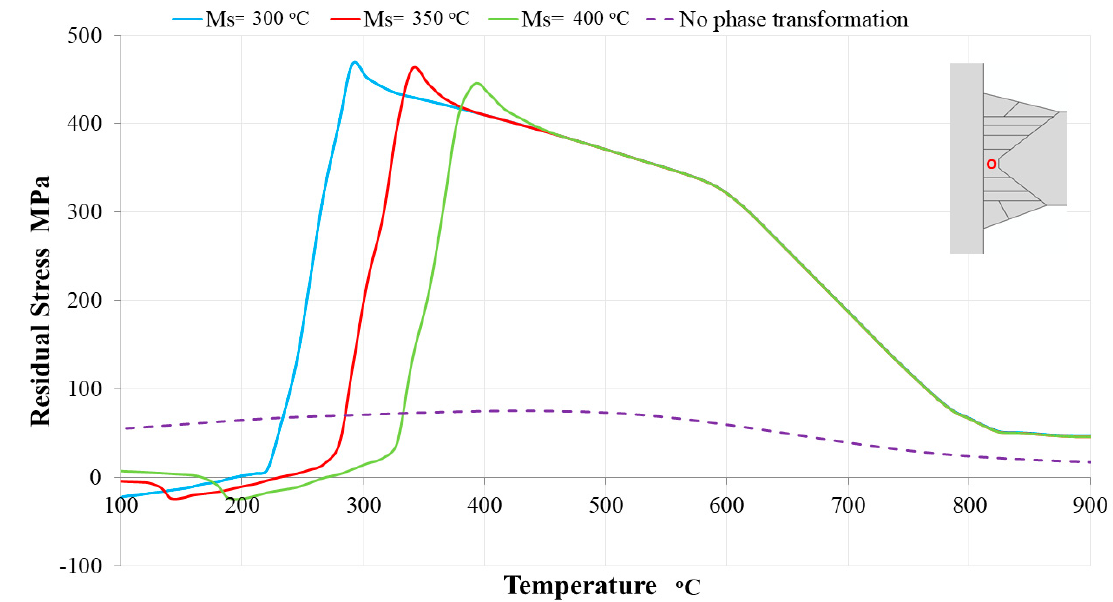
Figure 12. Stress accumulation at the 1 st bead.